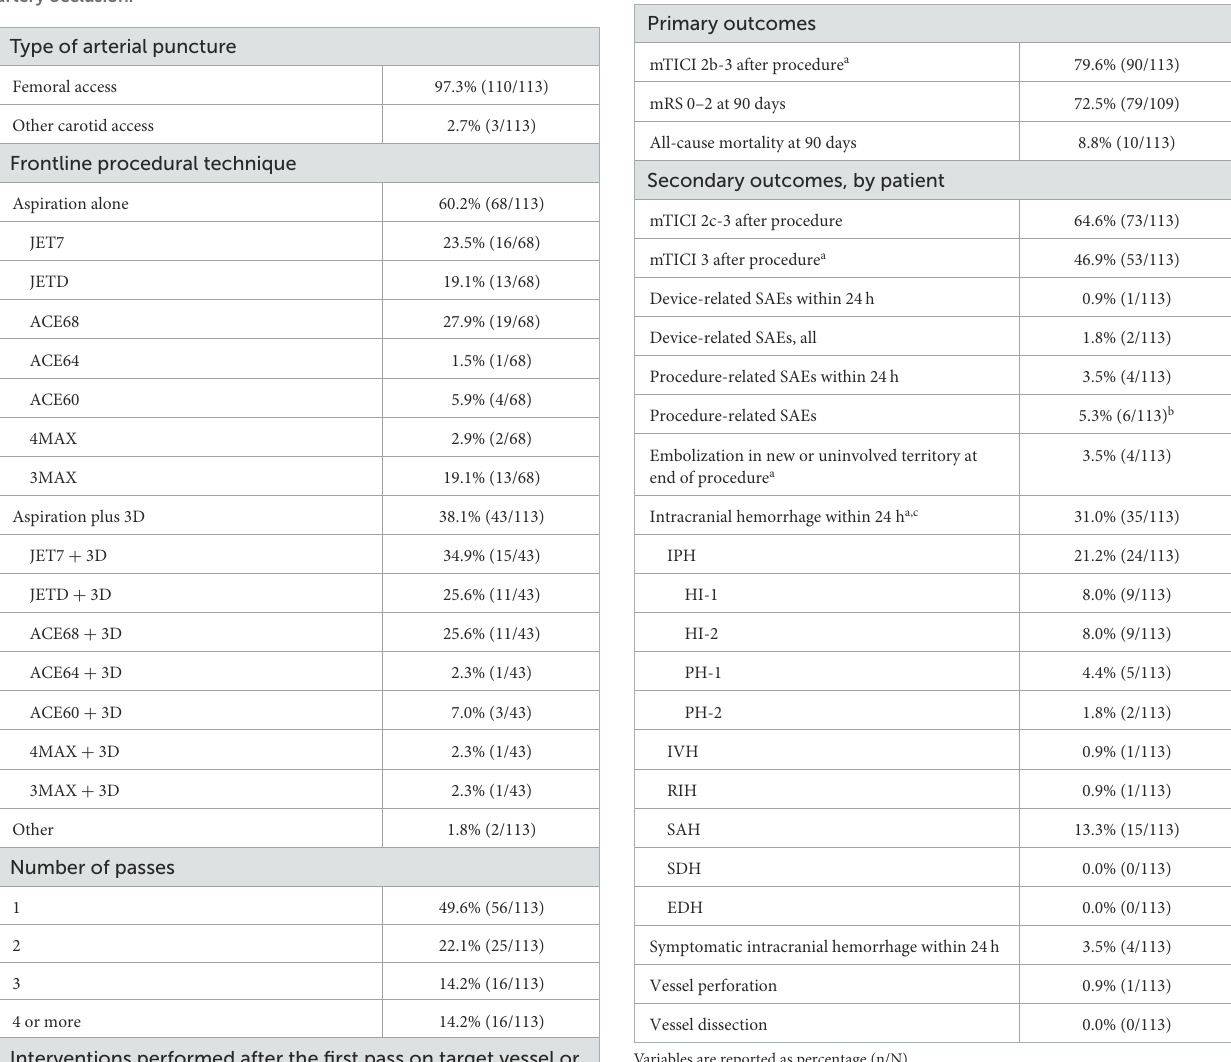
TABLE 2 Procedural information for patients treated with aspiration thrombectomy for acute ischemic stroke due to M2 middle cerebral artery occlusion.